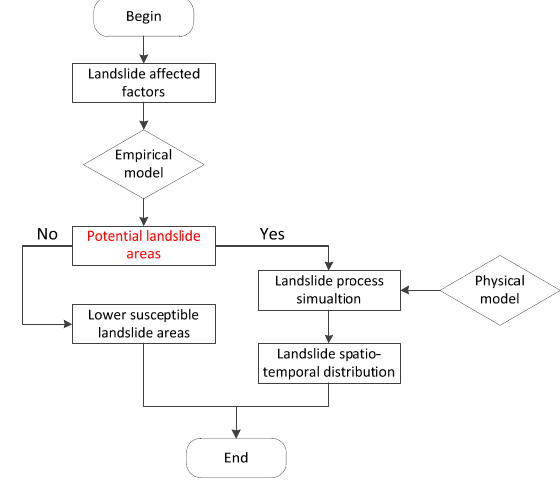
Figure 1. The systematic framework on multi-scale landslide hazard